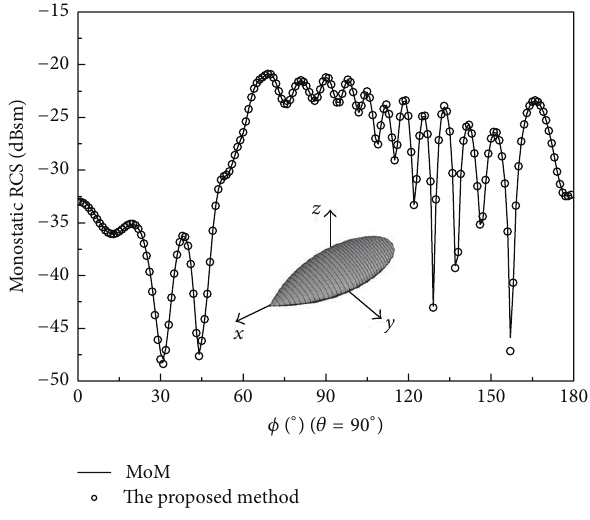
Figure 1: Monostatic RCS of PEC Almond model.